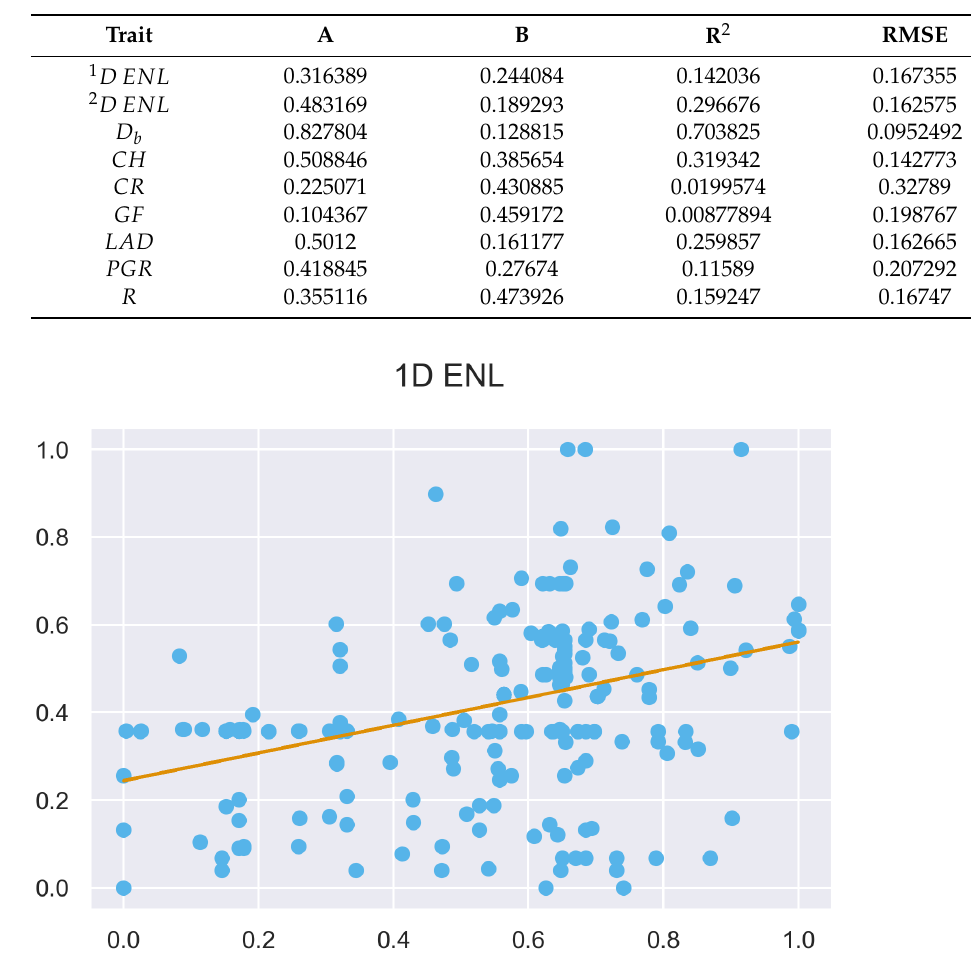
Table A19. Overview of linear regression between TLS and ULS at 5m grid size.